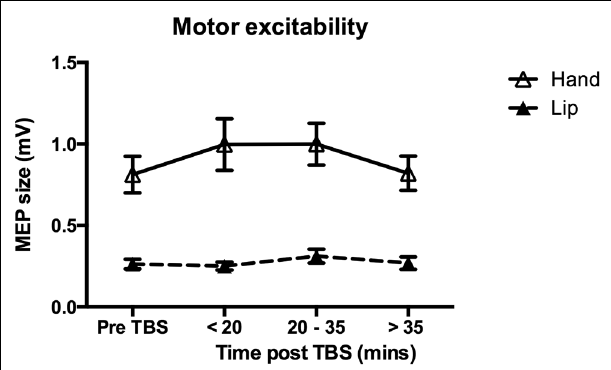
FIGURE 7 | Effect of cTBS on motor excitability. Group mean MEP sizes at each time point (pre-cTBS, early, middle and late post-cTBS) are shown for the target muscle in response to single-pulseTMS over either the Lip (dashed line) or the Hand (solid line) representation in M1. Error bars represent SEs of the mean.There was no significant change in excitability due to cTBS in either the Lip ( n = 12) or the Hand ( n = 11) group.The difference in amplitudes for the MEPs elicited in the Lip compared to the Hand muscle was expected as this was used in determining the thresholds separately for each muscle (see Section “Materials and Methods” for